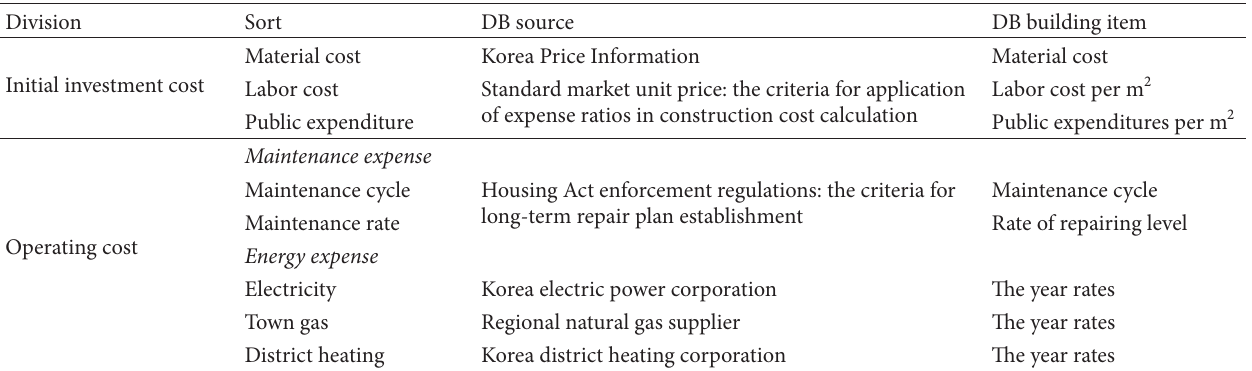
Table 2: Method of building the economic evaluation database and the item.